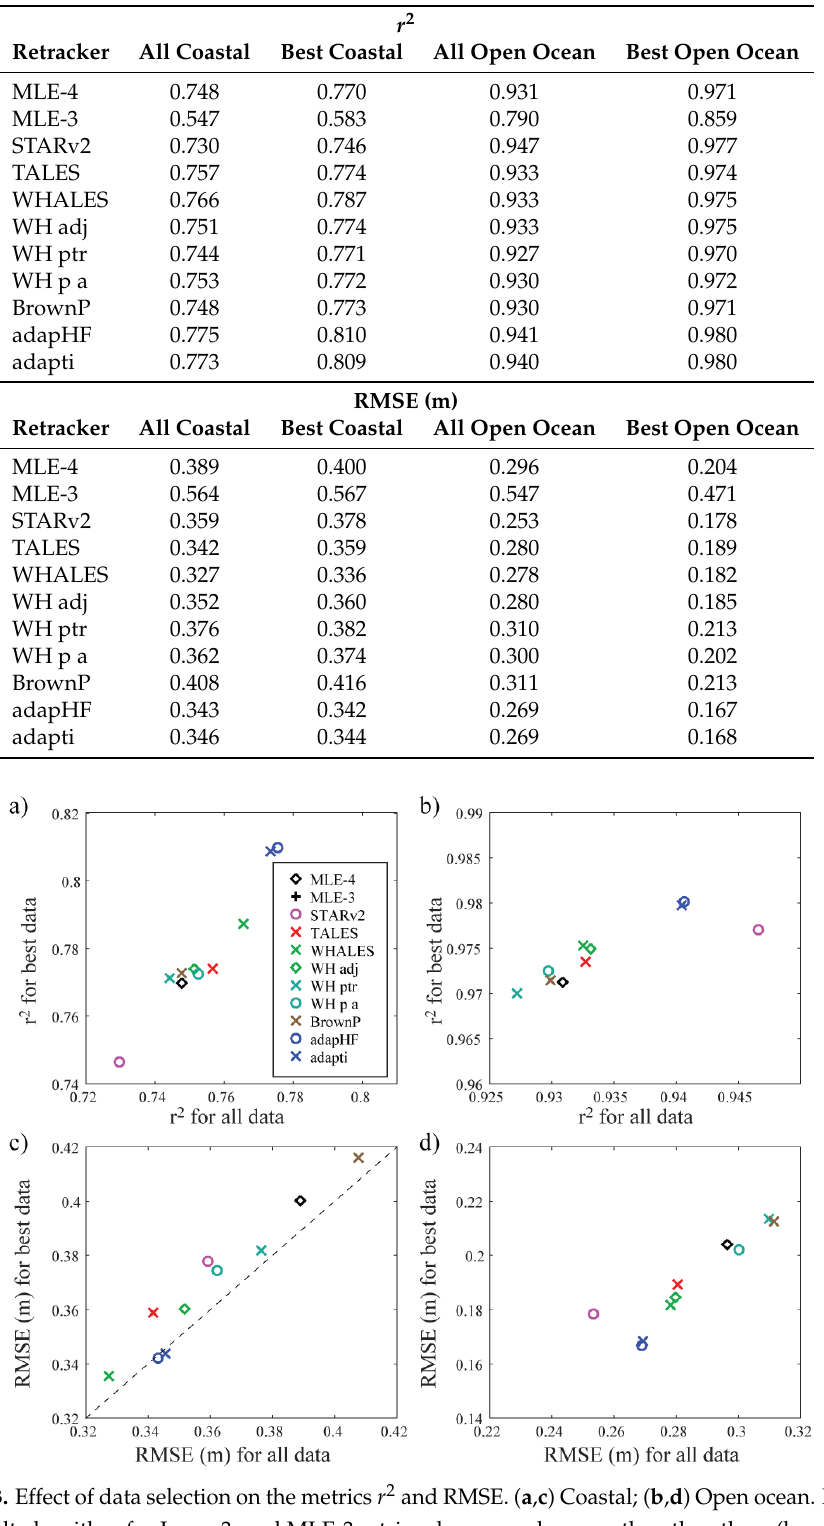
Table 2. Results for the different retrackers applied to Jason-3 data showing the effect of different buoy selection criteria. In all cases, a minimum of 20 valid SWH measurements along track is required.